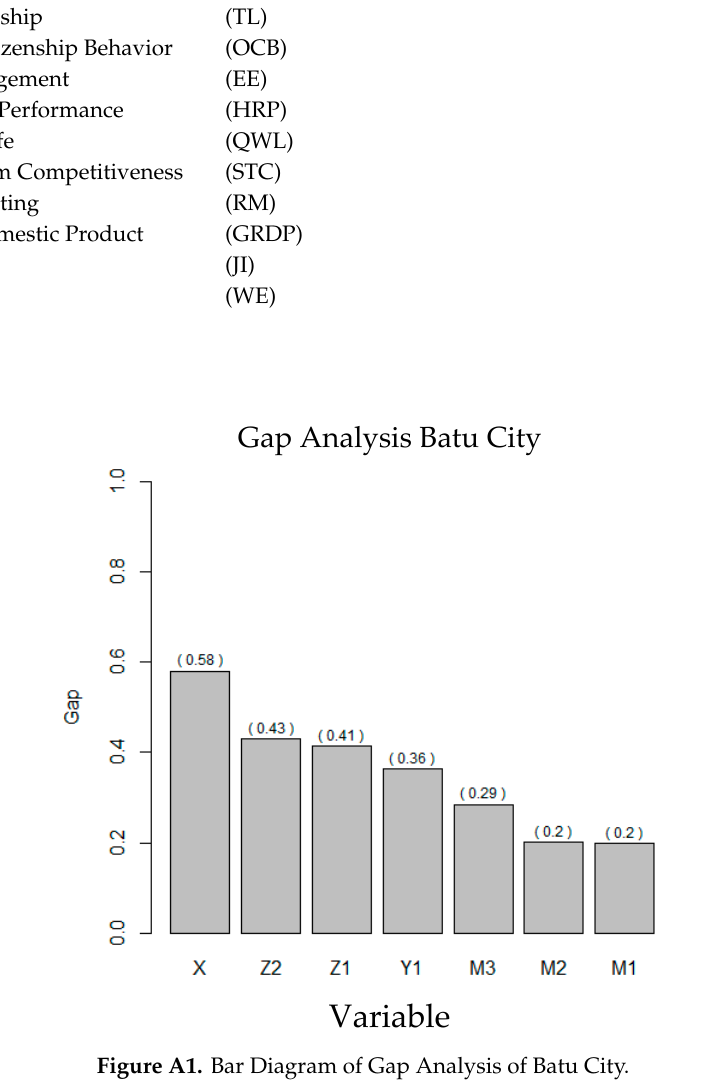
Variable Figure A2. Bar Diagram of Gap Analysis of Malang Regency. Gap Analysis Malang City